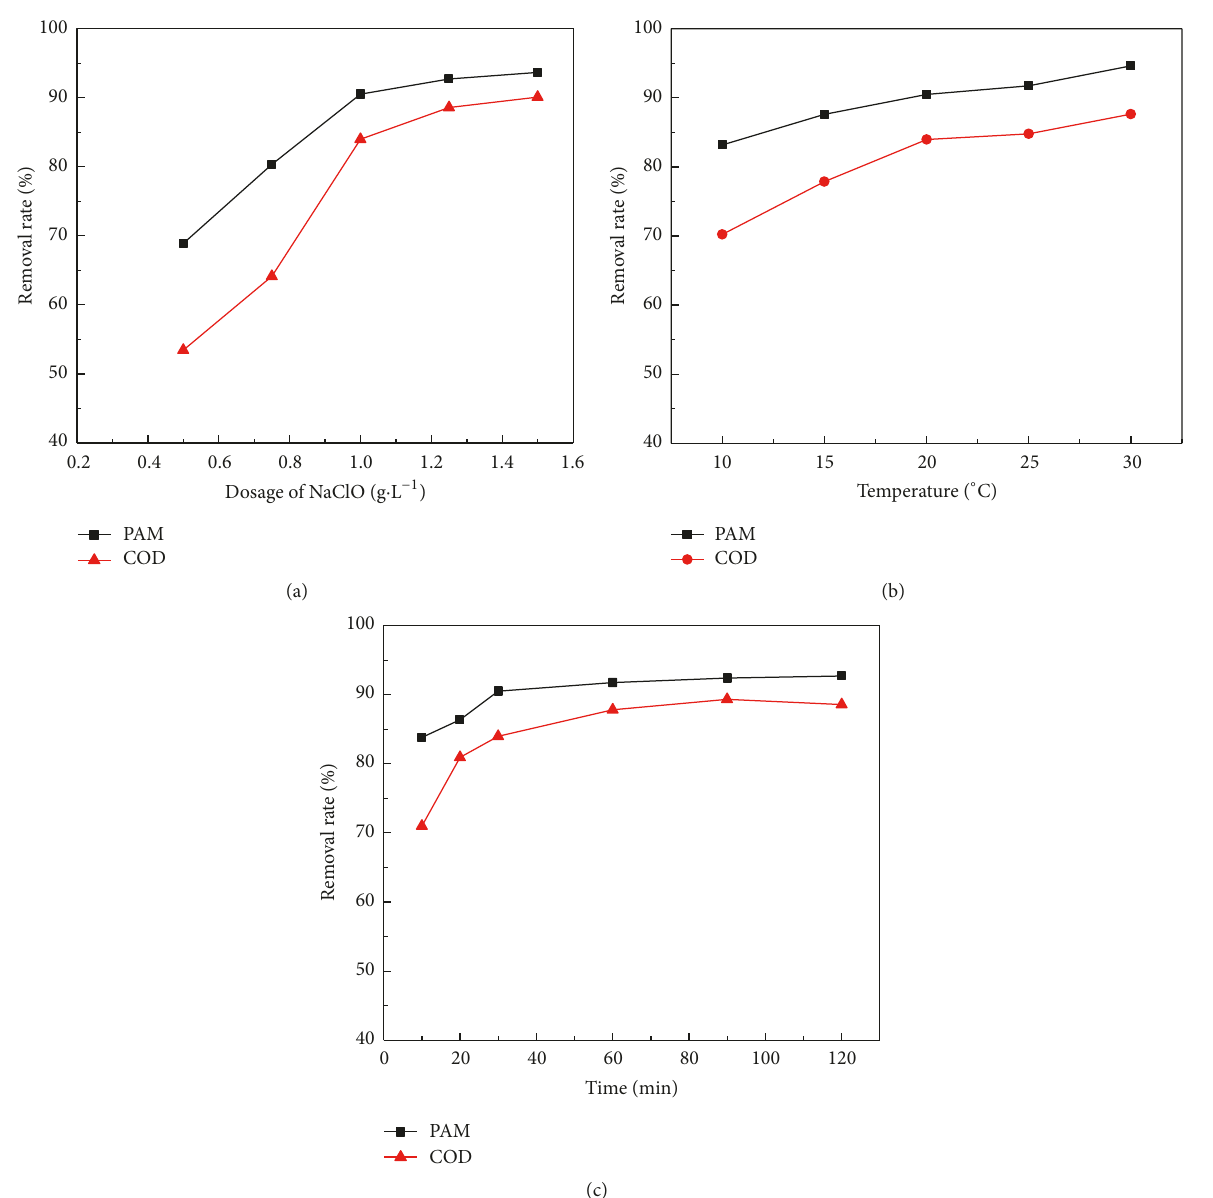
Figure 8: Effects of dosage of NaClO (a), reaction temperature (b), and reaction time (c) on the oxidation of tailings wastewater by using NaClO as oxidizing agent. Oximation conditions: (a) natural pH; temperature, 20 ∘ C; time, 30 min; (b) natural pH; dosage of NaClO, 1.0 g/L; time, 30min; (C) natural pH; dosage of NaClO, 1.0g/L; temperature, 20 ∘